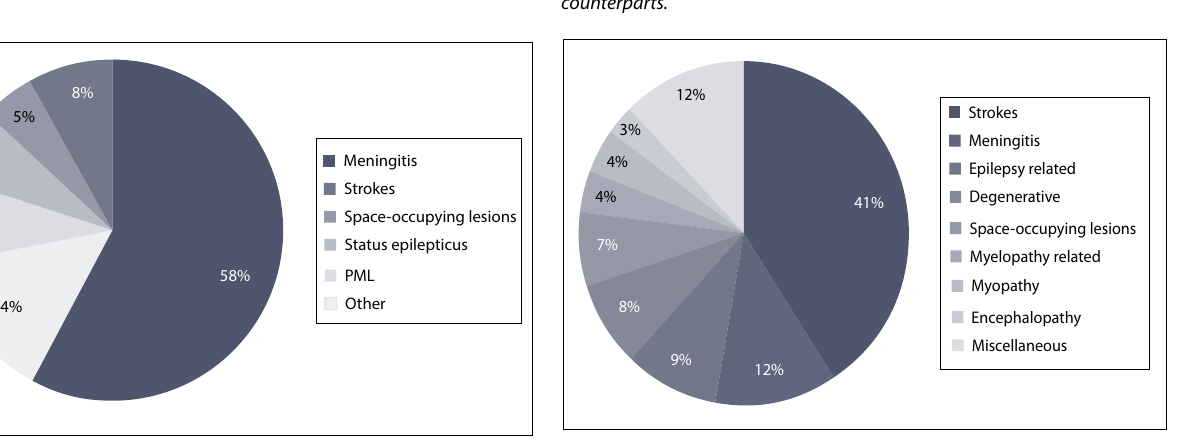
Fig. 3. Cause of death in the HIV-positive patients. Fig. 4. Cause of death in the combined HIV-negative and HIV-unknown